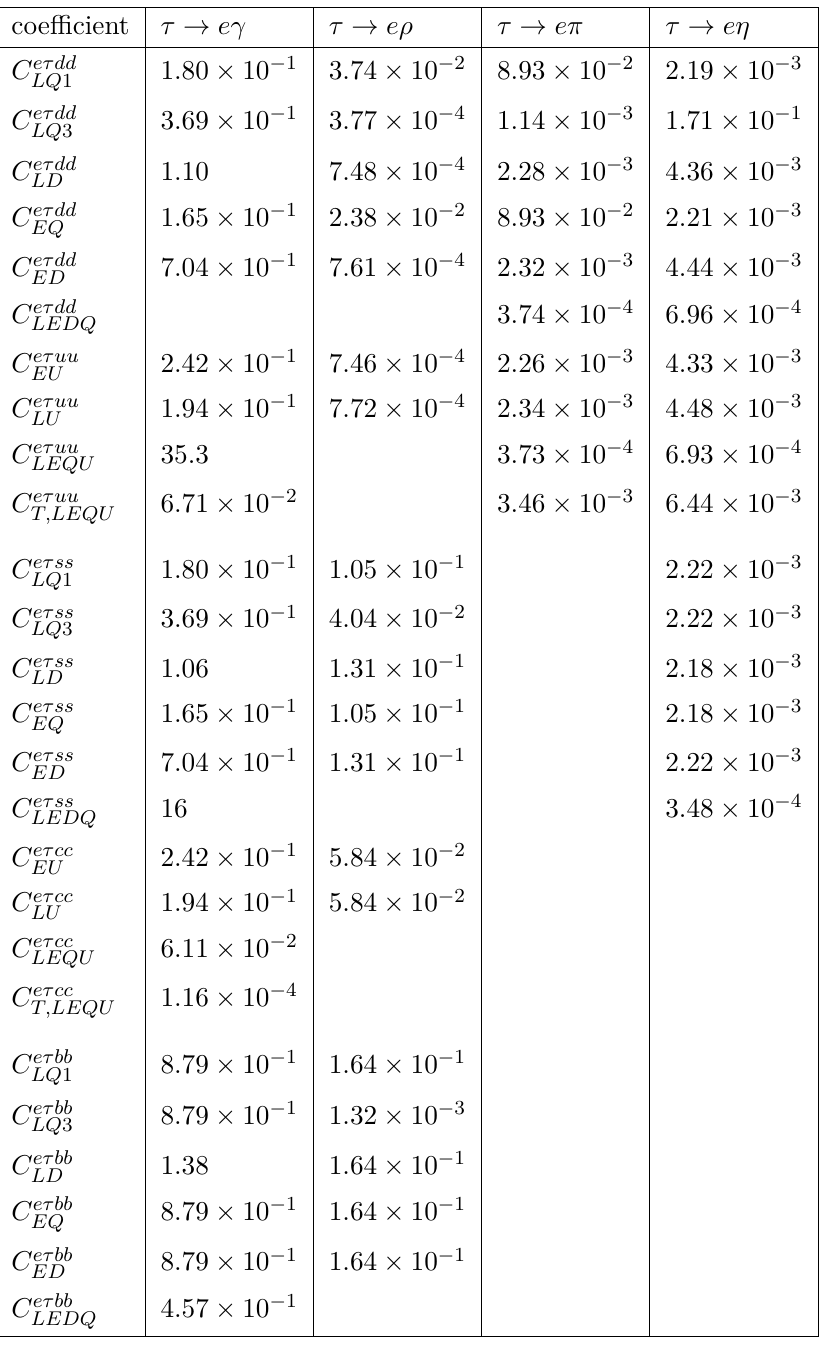
Table 10 . Current sensitivities of selected hadronic τ decays to the coefficients evaluated at m W of 2 ‘ 2 q SMEFT